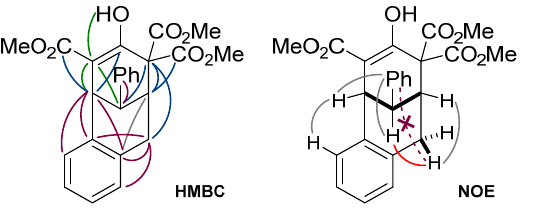
Figure 1. Structure and stereochemistry of the 9,10-dihydro-5,9-methanobenzo[8]annulene 3a